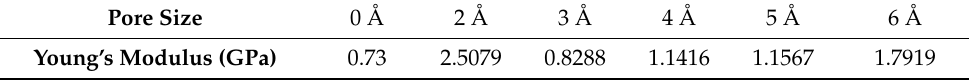
Figure 11. CaSO 4 · 2H 2 O surface pores and salt adsorption: ( a ) 2 Å pores, ( b ) 3 Å pores, ( c ) 4 Å pores, ( d ) 5 Å pores, and ( e ) 6 Å pores. (White balls are hydrogen, red balls are oxygen, yellow balls are sulfur, green balls are calcium, purple balls are sodium, and pink balls are aluminum). Table 4. Effects of pore size on the mechanical properties of CaSO 4 · 2H 2